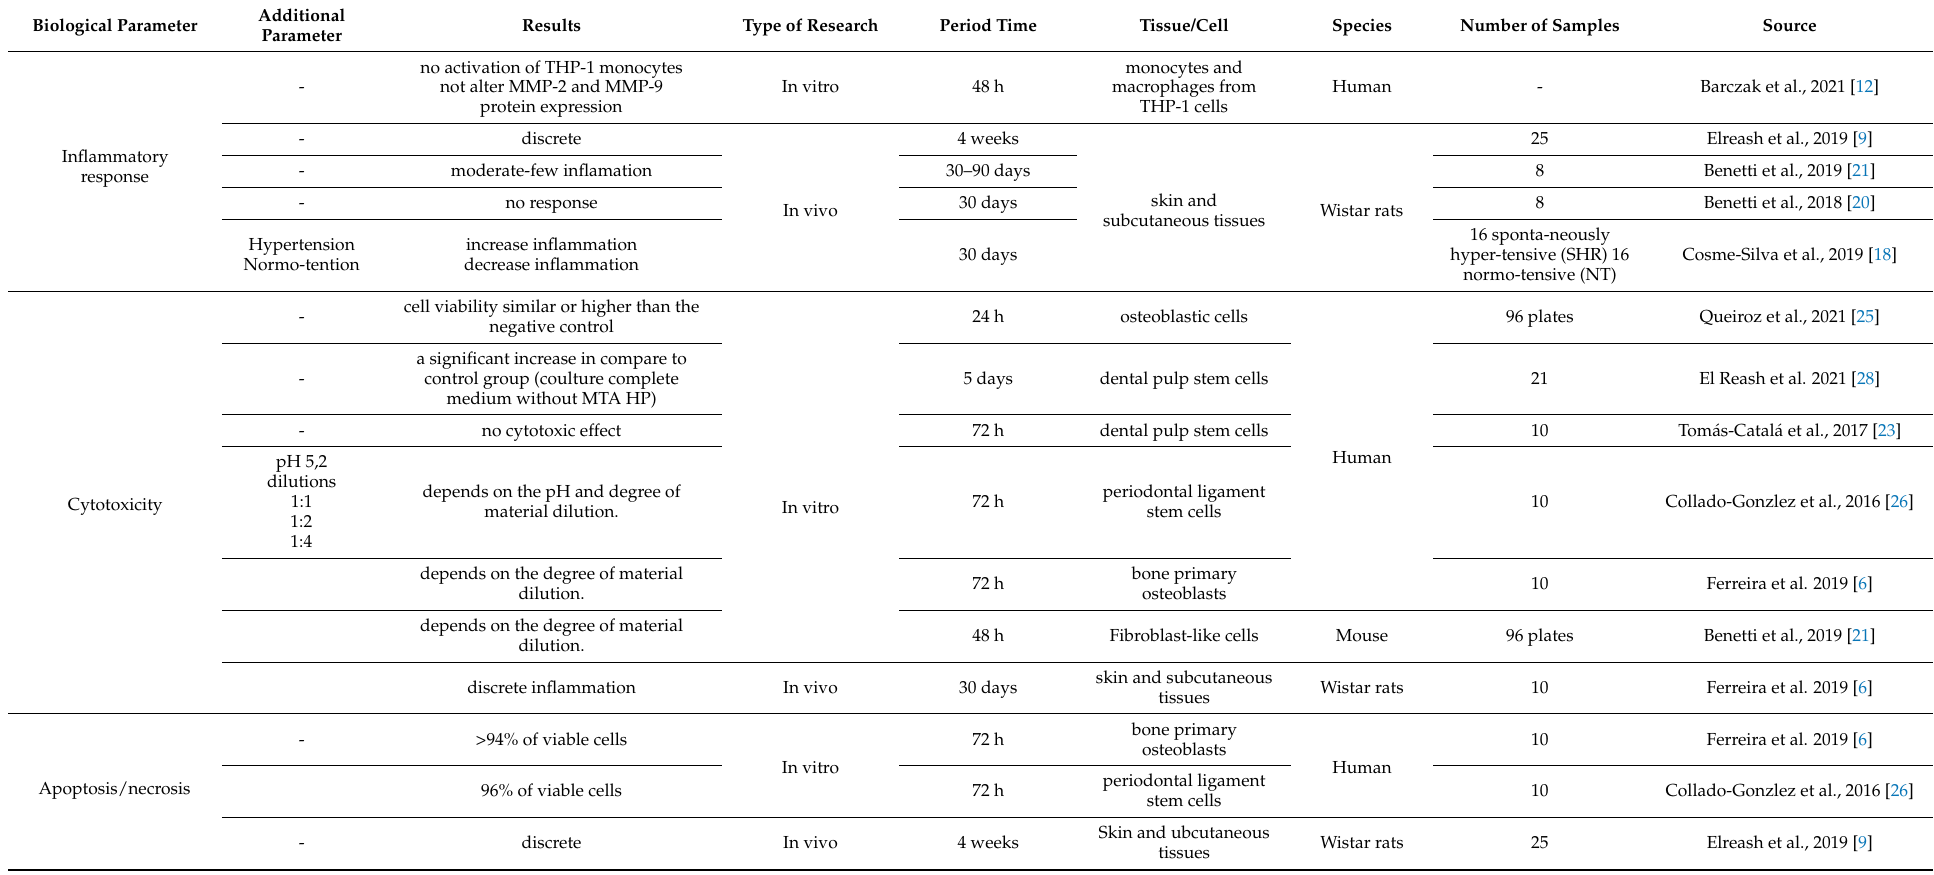
Table 7. Selected biological parameters of the MTA